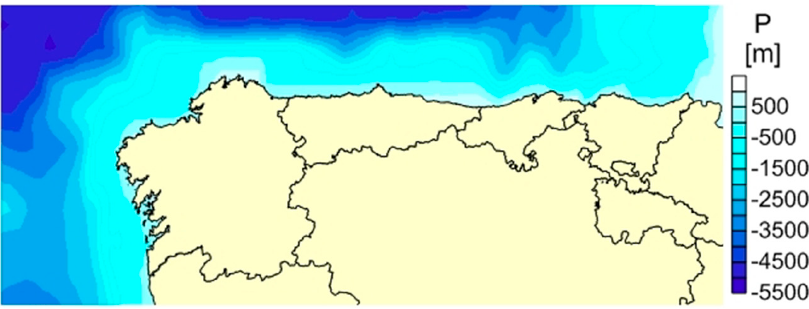
7 of 16 Figure 3. Shape of the offshore wind parameter for the North of Spain.